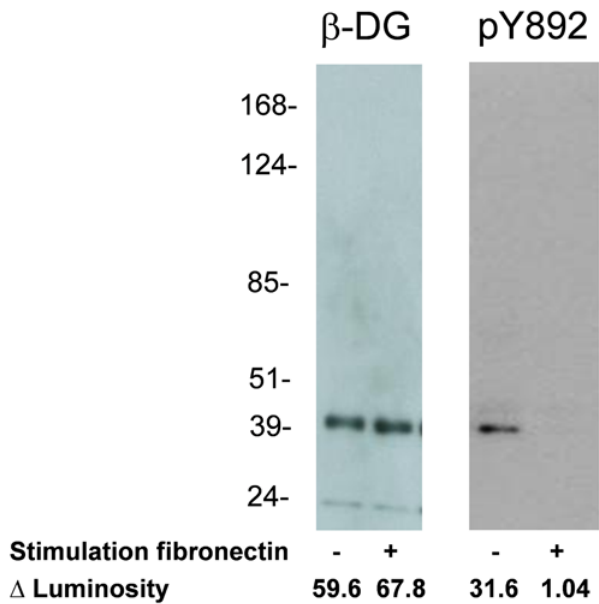
Figure 3. Fibronectin stimulation of cultured mouse podocytes leads to a decrease of pY892 on b -dystroglycan. Cultured mouse podocytes were incubated for 3 minutes with fibronectin after which a decrease of pY892 was found in Western blot analysis of whole podocyte cell lysates (right panel), whereas the total amount of b - dystroglycan was not affected (left panel). Total b -dystroglycan was probed with NCL-BDG and pY892 was probed with anti-pY892.